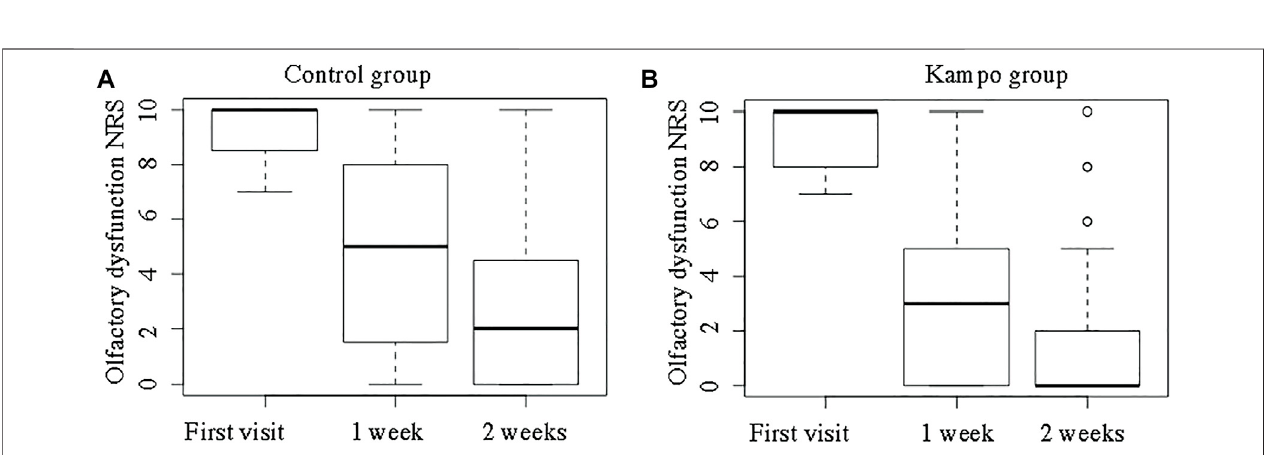
FIGURE 5 | Olfactory dysfunction Numeric Rating Scale scores in the control and Kampo groups. (A) ; Control group, (B) ; Kampo group.